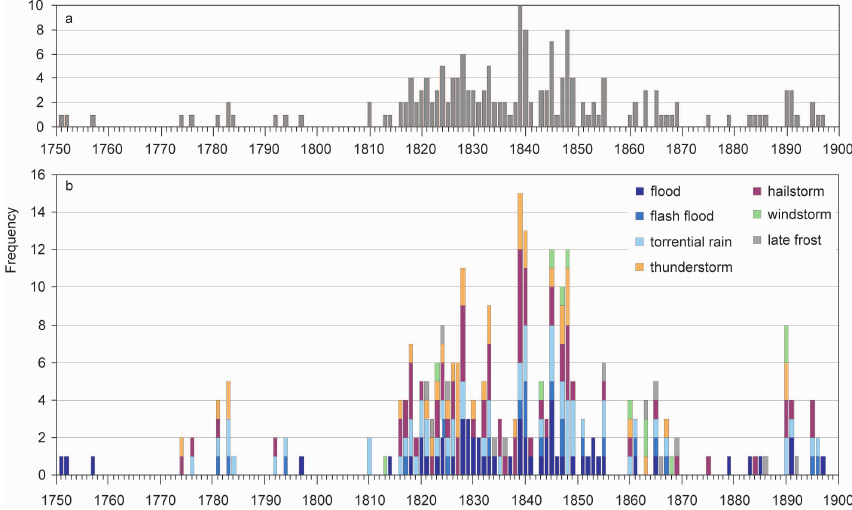
Fig. 3. Annual frequency of reported (a) total extreme hydrometeorological events and (b) individually classified types of extremes in south-eastern Moravia during the 1751–1900